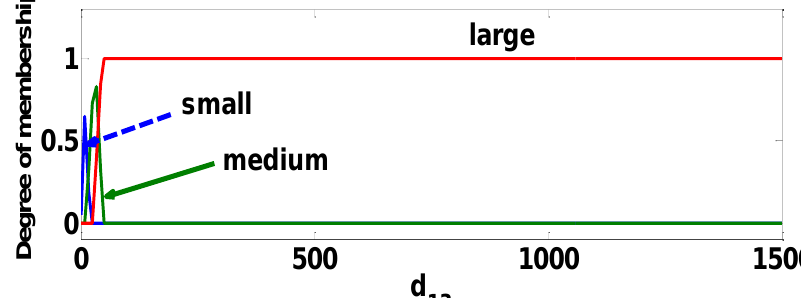
Figure 13. Membership functions for the distance 𝑑 12 .